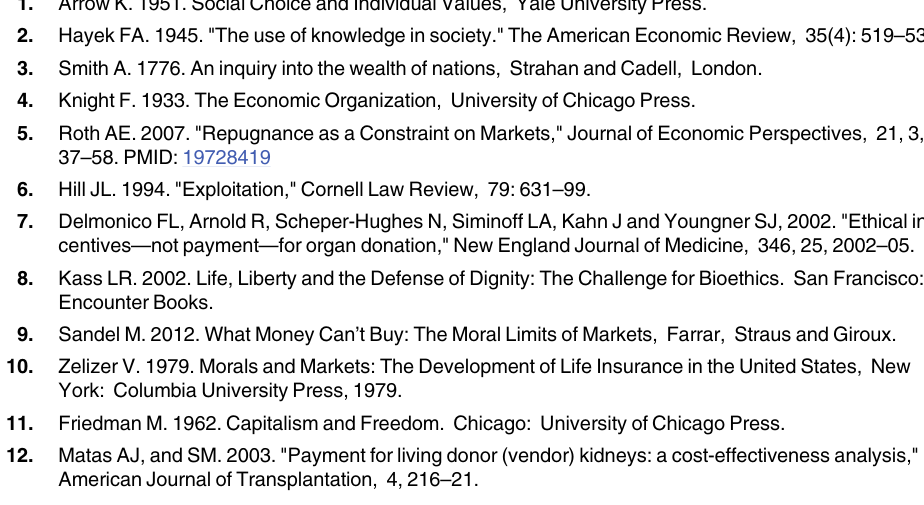
S2 Table. Comparison between the mTurk sample and the US population on selected socio- economic characteristics. Notes: Figures on the US population are from Leider and